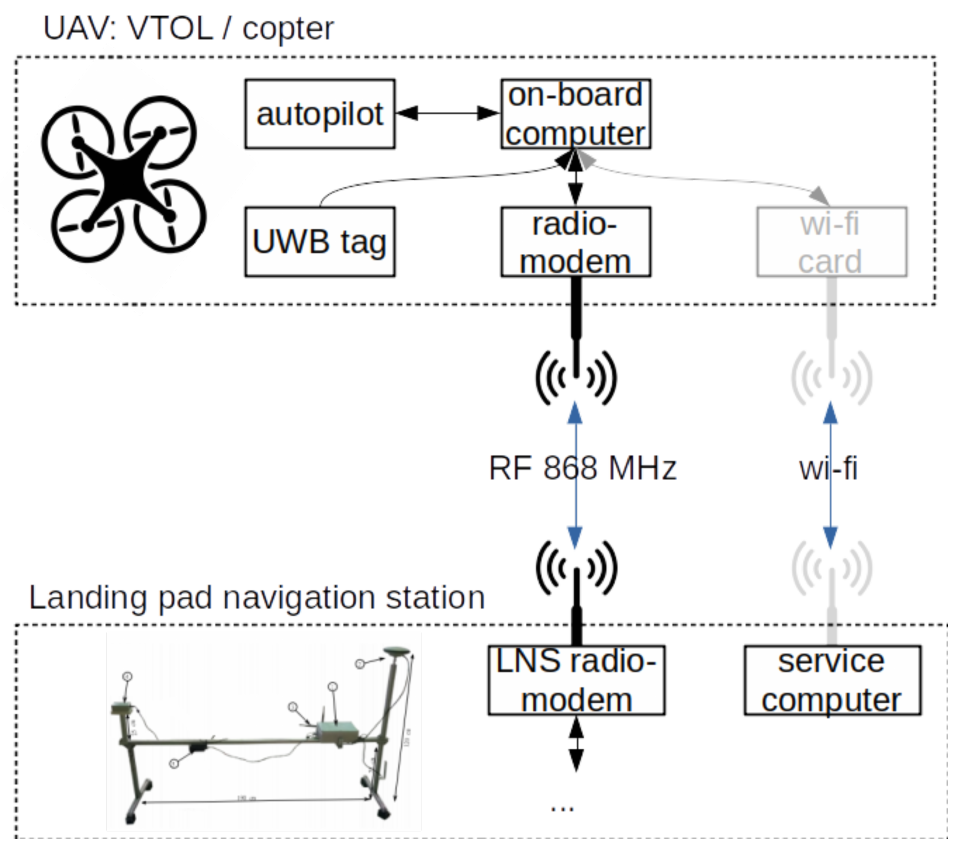
Figure 8. Diagram of onboard system